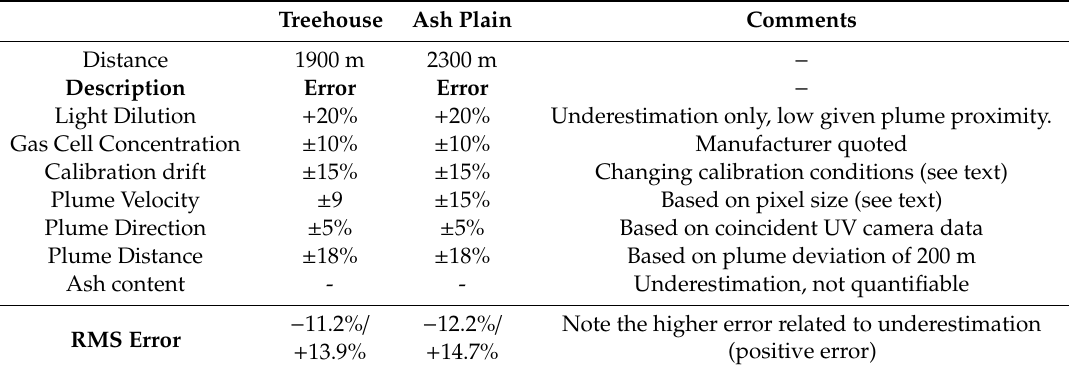
Table 1. A summary of errors from UV camera measurements of SO 2 fluxes at Yasur volcano in July 2018, including short comments and the total root-mean-square (RMS) error. The bold emphasise di ff erent bits of data